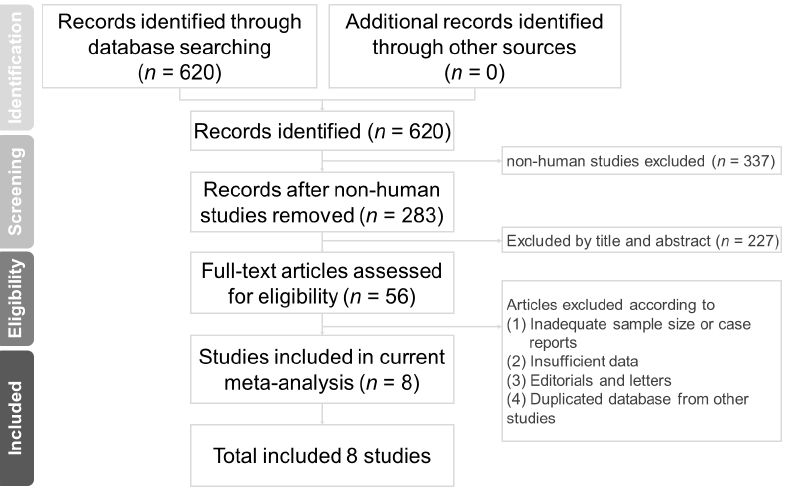
Figure 1. Flowchart of studies included and excluded.